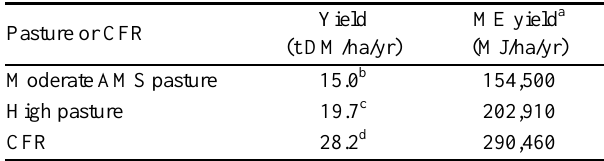
Table 1. Scenarios of herd size and complementary forage system Table 2. Pasture and forage yield used in the model and analysed in the study calculated potential metabolisable energy (ME) yield (MJ/ha) from home-grown pastures and complementary forage Complementary forage system (pasture plus CFR) Herd size (no.)